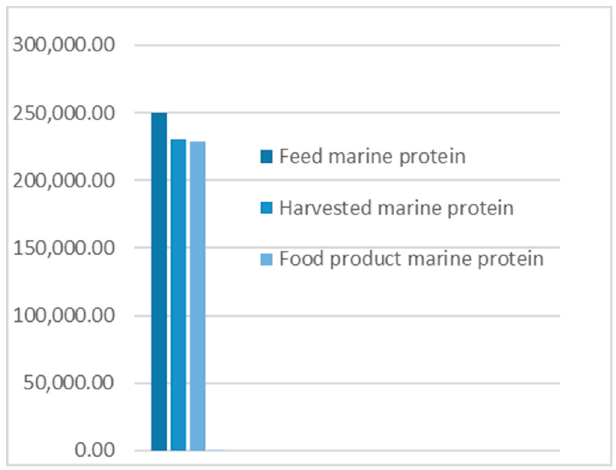
Figure 6. Alternative scenario post-harvest protein distribution. Foods 2020 , 9 , x